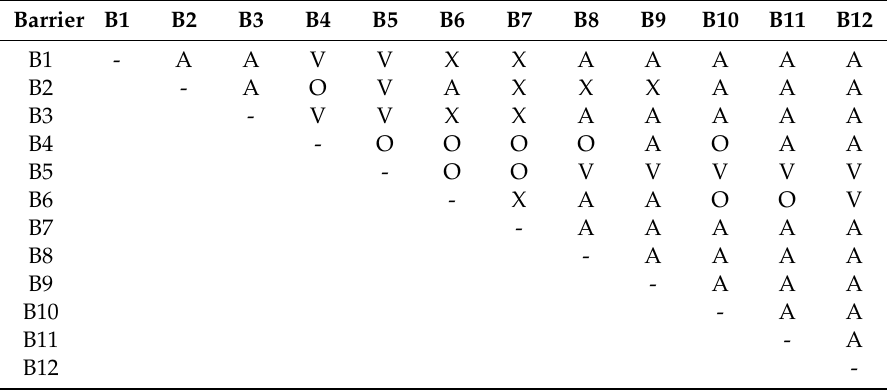
Table 2. The structural self-interaction matrix (SSIM).